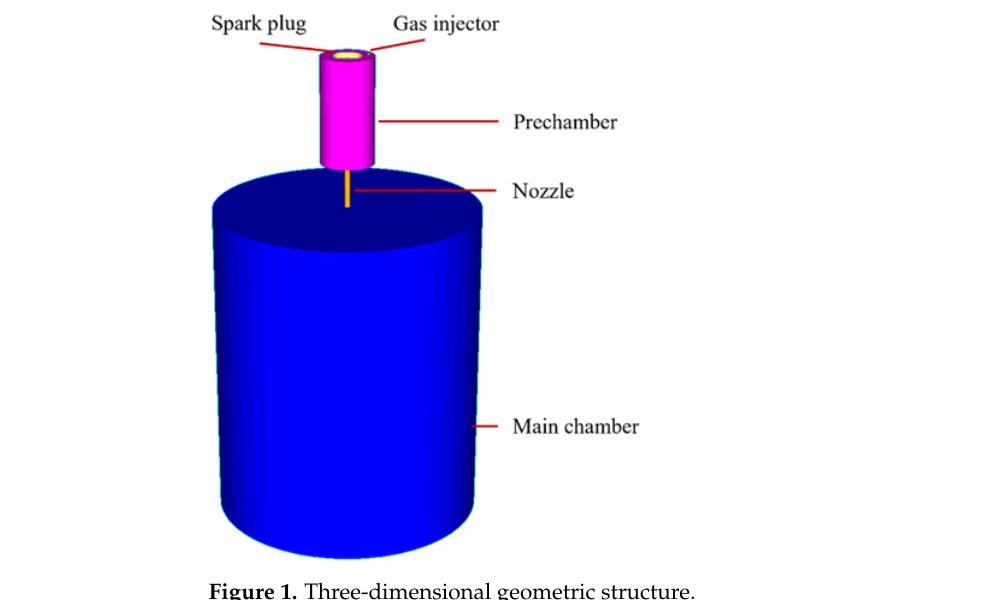
Figure 1. Three-dimensional geometric structure.